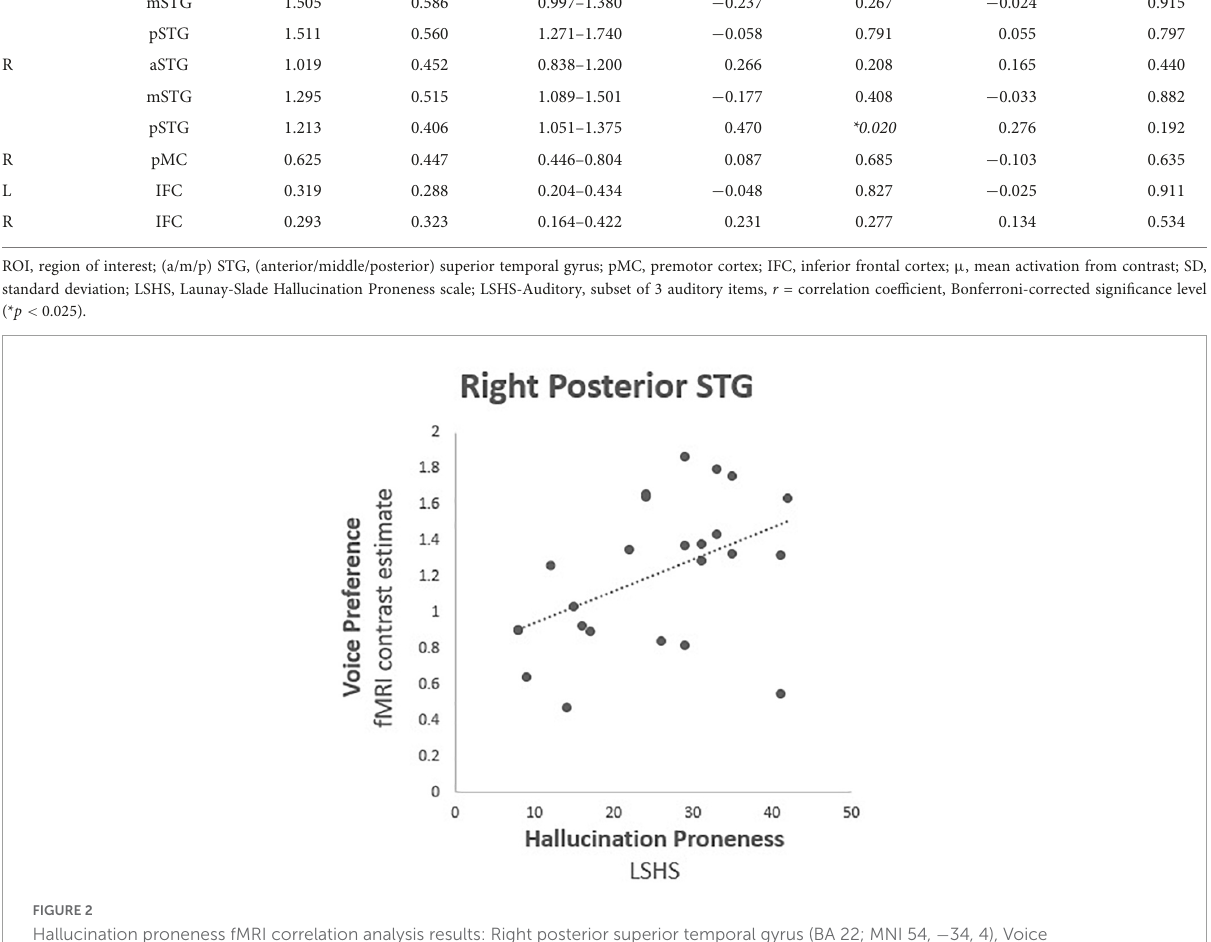
TABLE 2 Voice preference response [(Voice > Silence) > (Non-voice > Silence)] correlation with hallucination proneness results. ROI LSHS LSHS-Auditory Hem.